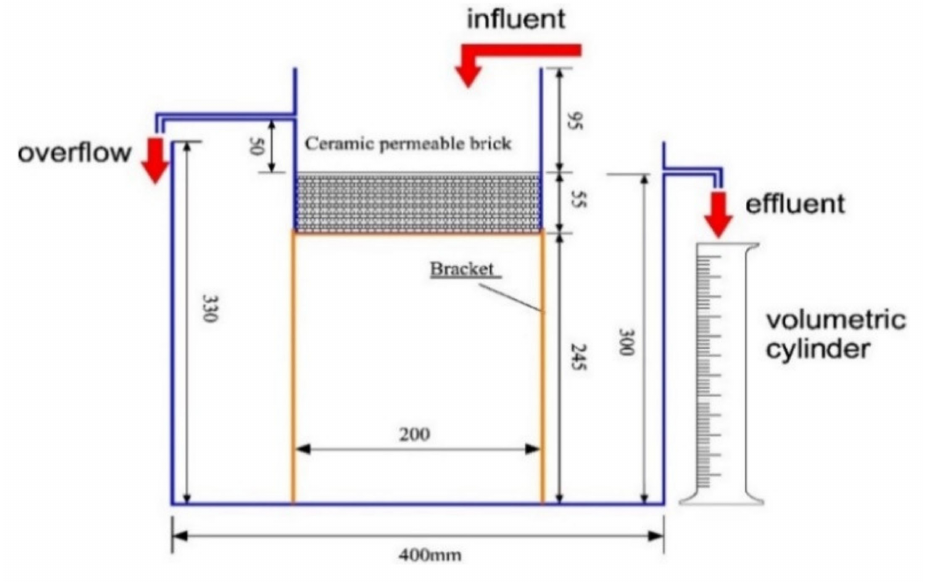
Figure 4. The experimental